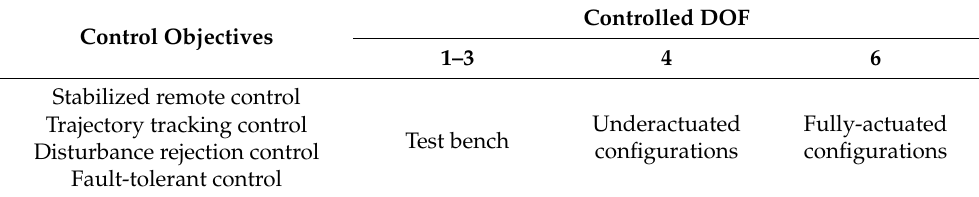
Table 2. Educational objectives in course related to UAV mechatronics. Control